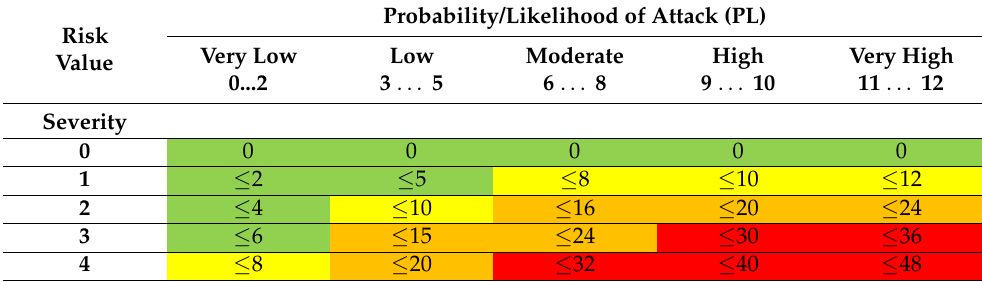
Table 15. Cybersecurity: risk